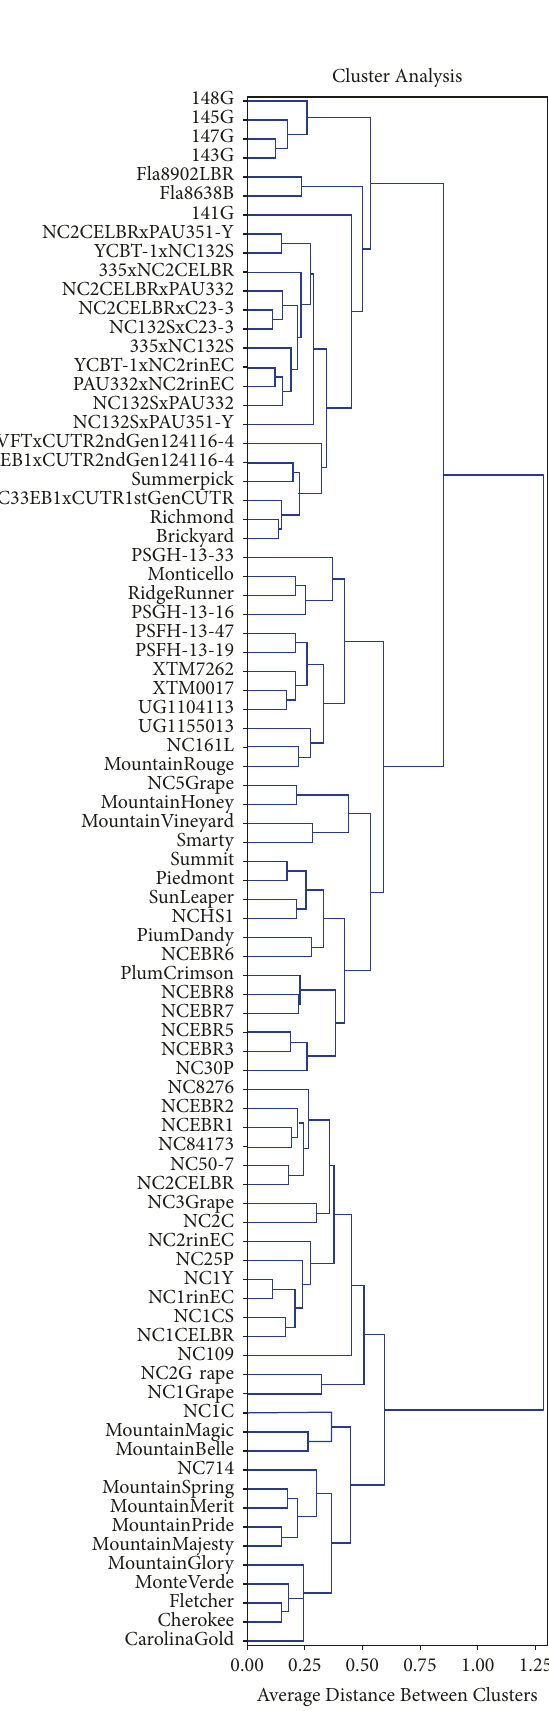
Figure 15: Cluster analysis of ninety-one fresh-market tomato genotypes based on average distance